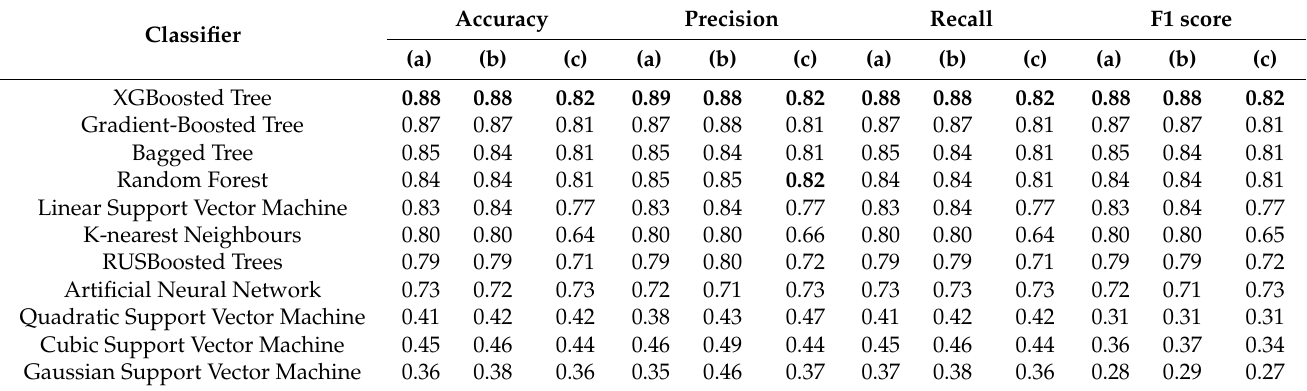
Table 3. Performance metrics for the various classifiers and using three cross-validation methods: ( a ) 10-fold cross-validation, ( b ) stratified 10-fold cross-validation and ( c ) group cross-validation with 24 splits. Bold values show the best score for each performance